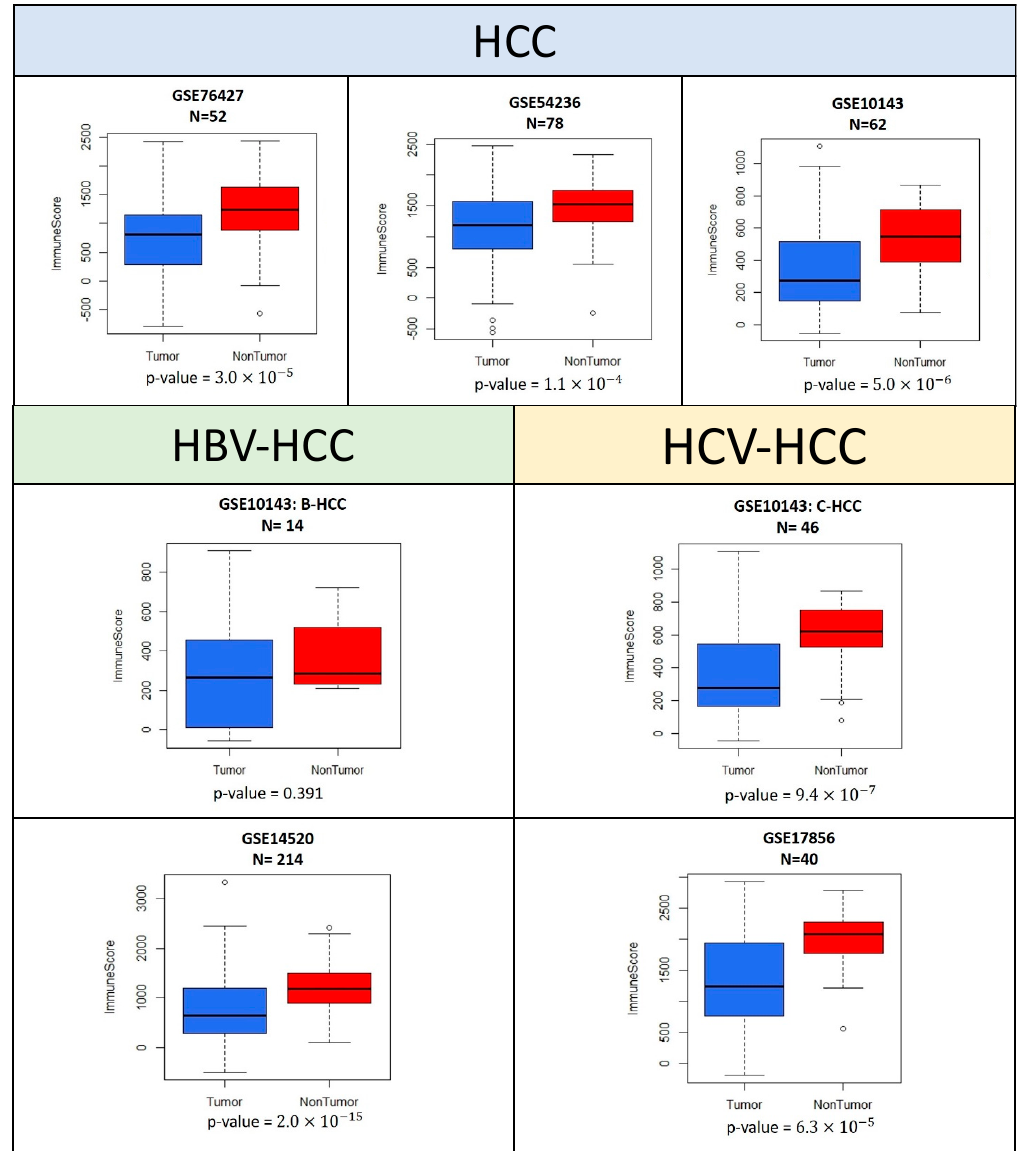
Figure 2. Immune scores for intra-tumor and non-tumor samples from hepatocellular carcinoma patients. The five datasets (GSE76427, GSE54236, GSE10143, GSE14520 and GSE17856) with paired data were quantile normalized and the normalized data were then fed into ESTIMATE software for the calculation of immune scores. p -values were obtained by Wilcoxon signed-rank tests.